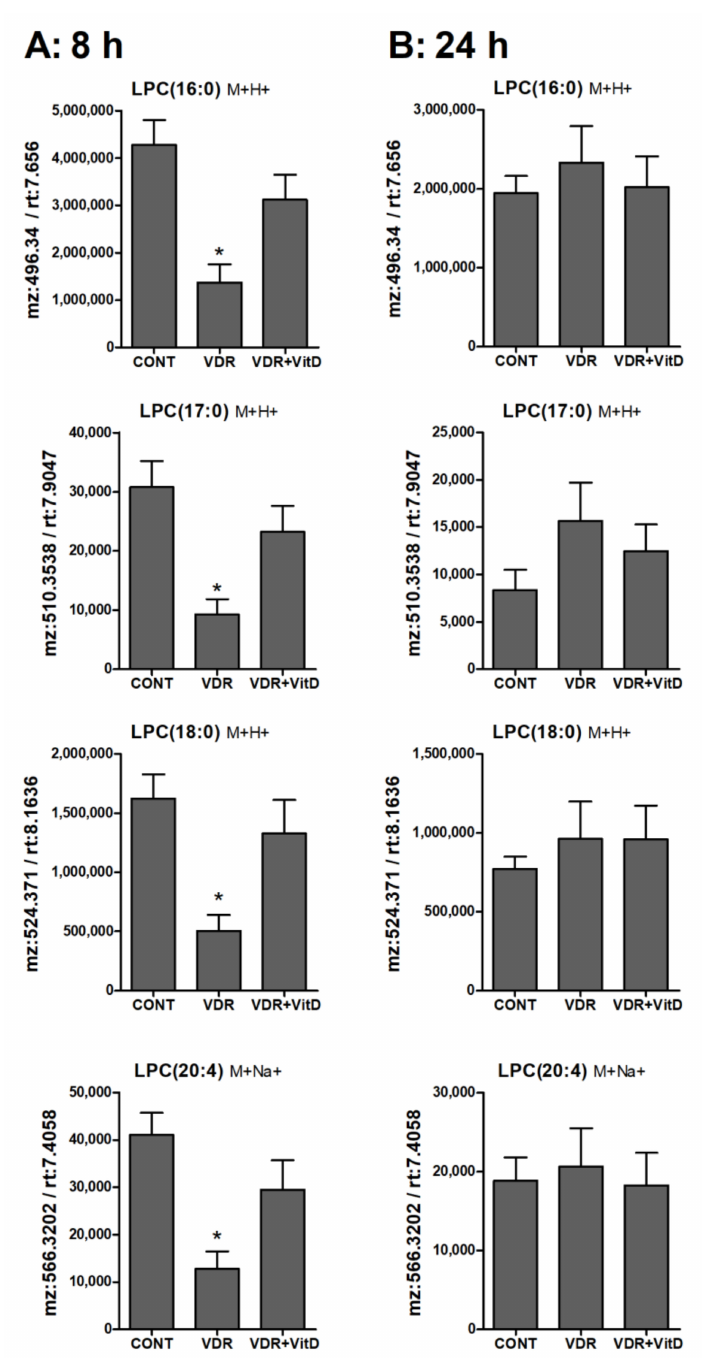
Figure 7. Relative intracellular levs of selected lysophosphatidylcholines in cultured human hepatocytes exposed to VitD. Upcyte hepatocytes were transfected with control Ad-C or with Ad-VDR for 48 h. Then, 10 nM VitD (VDR + VitD, n = 4) or vehicle (CONT, n = 3 and VDR, n = 4) were added for 8 ( A ) or 24 h ( B ). Cells were washed, and intracellular metabolites extracted and analyzed by UPLC-MS as described in Materials and Methods. * p < 0.05 VDR vs. VDR +